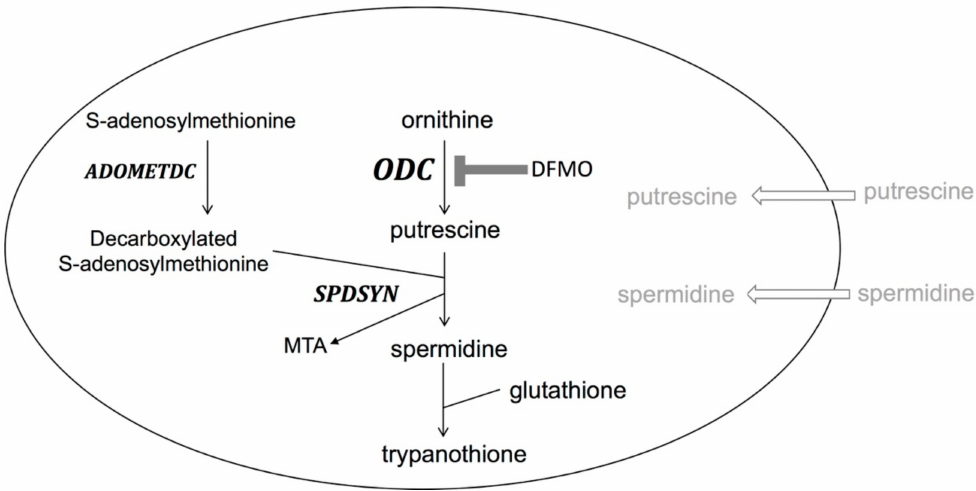
Figure 3. The polyamine pathway in Trypanosoma brucei. Trypanosoma brucei parasites lack ARG, SPMSYN, and a back-conversion pathway. Unique to trypanosomatids is the formation of trypanothione, a conjugate of spermidine and glutathione. Polyamine import is minimal as